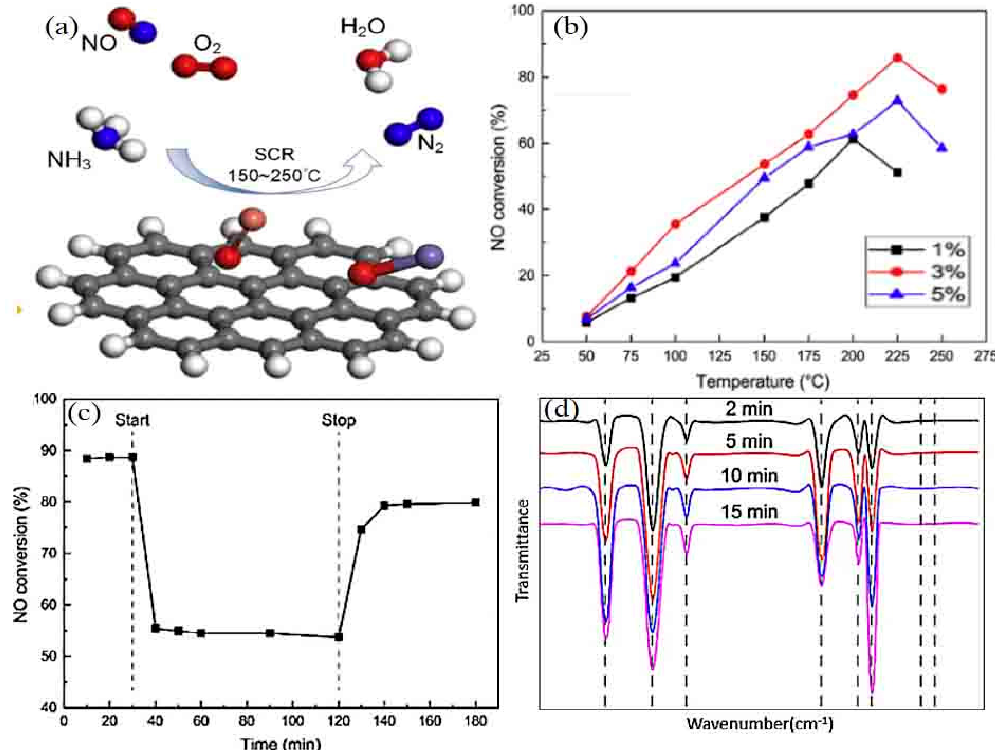
Figure 2. ( a ) Adsorption process of NO on activated carbon surface, ( b ) effect of adding O 2 on NO conversion, ( c ) study on SO 2 resistance of Cu-Fe / MCSAC catalyst, and ( d ) in situ infrared analysis of Cu-Fe / MCSAC after SO 2 entering gas pool [61]. Reproduced from Ref. [61], Copyright 2019, Elsevier. Table 1. Effect of different adsorption materials on NO conversion.